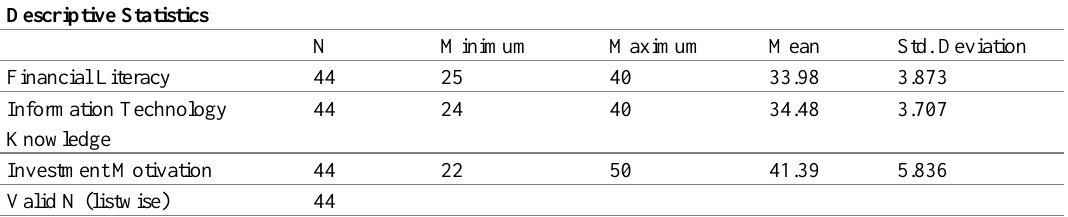
Table 1 . Descriptive Analysis